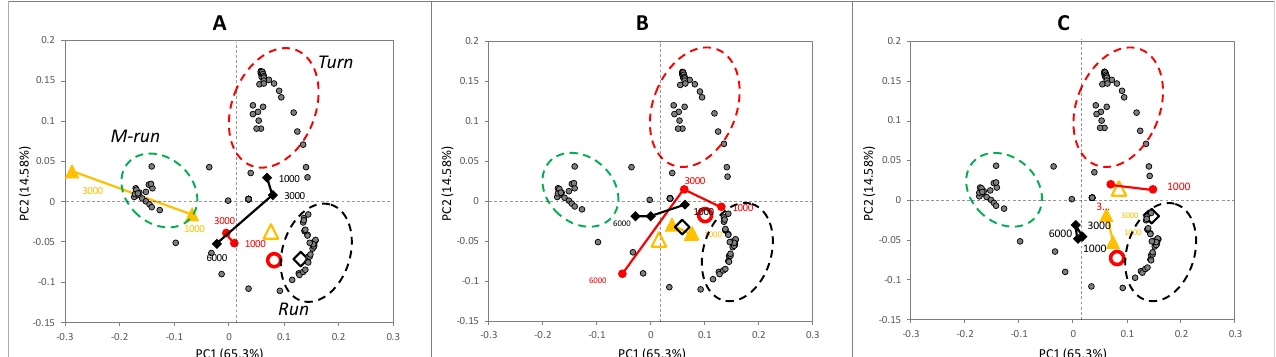
Figure 5. Biplots of the space of variance generated in the PCA study from the postural dynamics data (Block B). ( A ): the score distribution of the treatments with no ascorbic acid pre-exposure; ( B ): the score distribution of the treatments with the 5 mM ascorbic acid pre-exposure; ( C ): the score distribution of the treatments with the 10 mM ascorbic acid pre-exposure. AA: yellow triangles; PA: black diamond; PP: red circles. Empty symbols represent the control cases (without nitrite). Dotted circumferences indicate the accumulations of % worm length from the postural spectra corresponding to turn (red), run (black) and M-run (green).